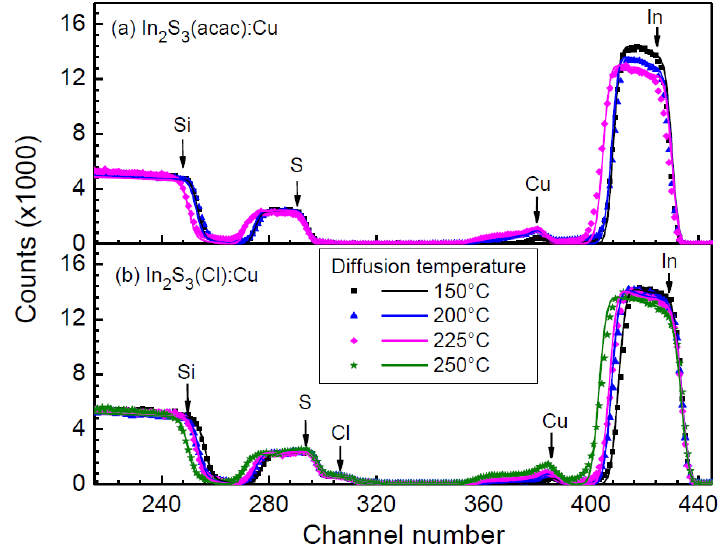
Figure 1. RBS spectra for ( a ) In 2 S 3 (acac):Cu and ( b ) In 2 S 3 (Cl):Cu after diffusion of Cu at different temperatures. The respective peaks are